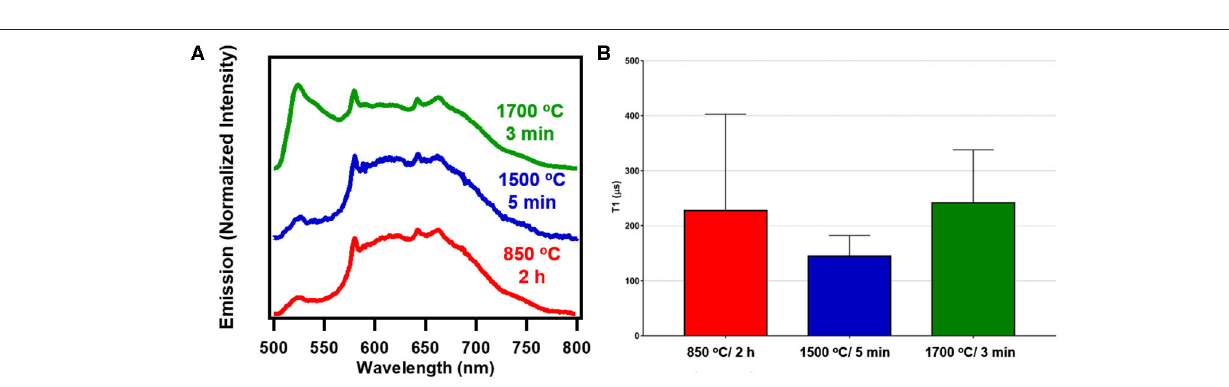
FIGURE 6 | (A) Spectra of 140nm fluorescent nanodiamond studied under blue broadband excitation (470/28nm excitation and 488nm long pass emission). (B) Combined average T 1 values for 140nm fluorescent nanodiamond particles. Statistical analysis shows that there is no significant difference between the different samples. The combined average is obtained from taking a combined curve for each particle measured and averaging the T1 values obtained from these combined curves. See Supplementary Material for additional